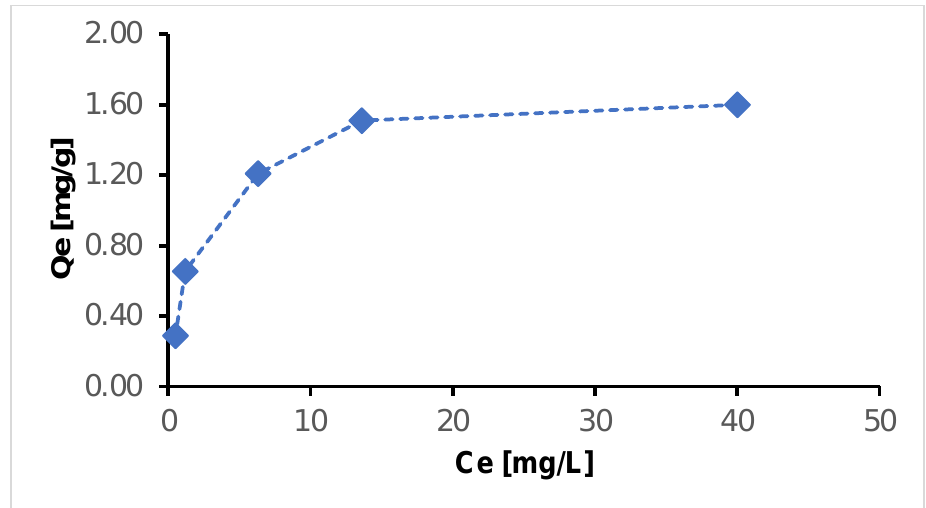
Figure 3. Phosphorus adsorption on dynamic membrane adsorber.